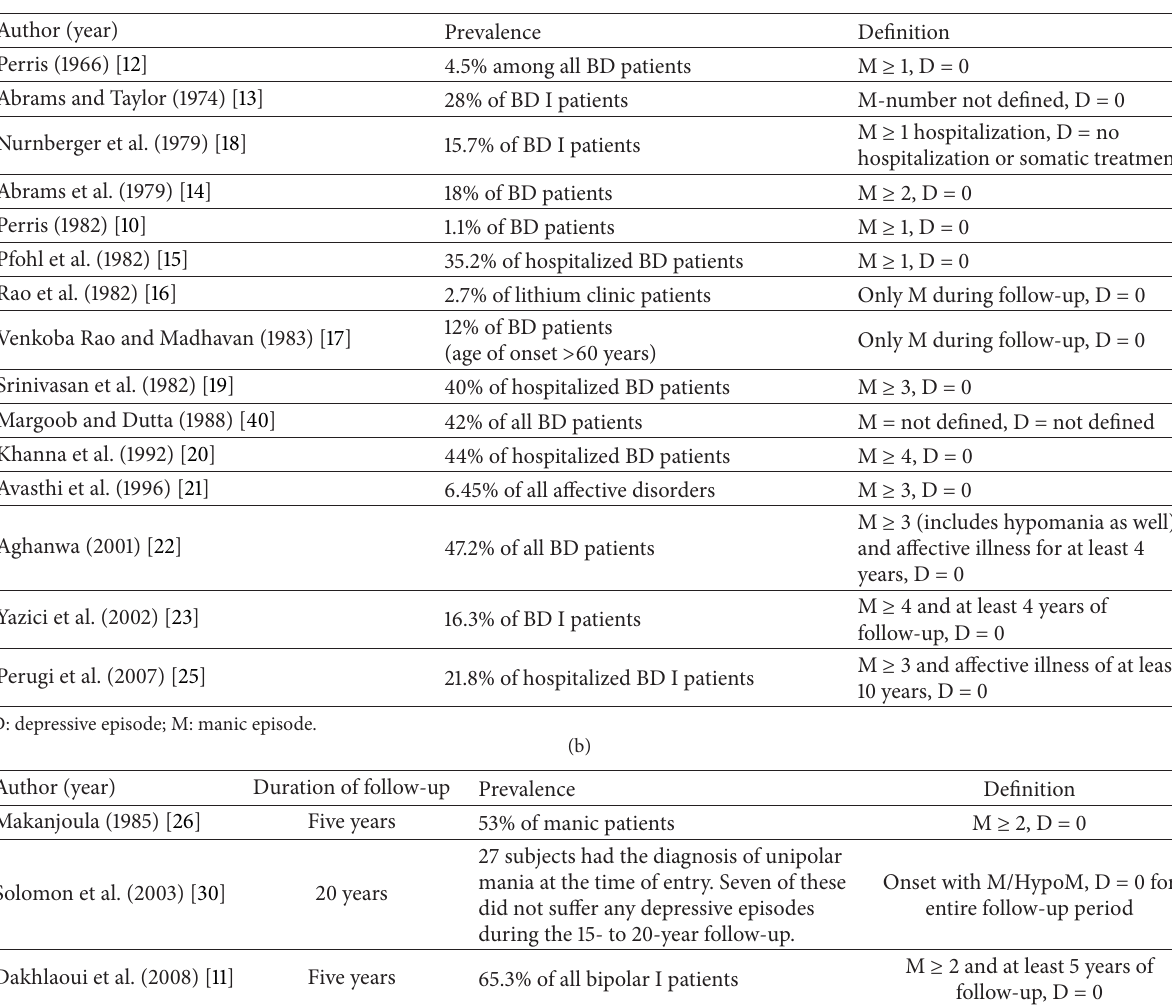
Table 1: (a) Retrospective studies related to prevalence of UM. (b) Prospective studies related to prevalence of